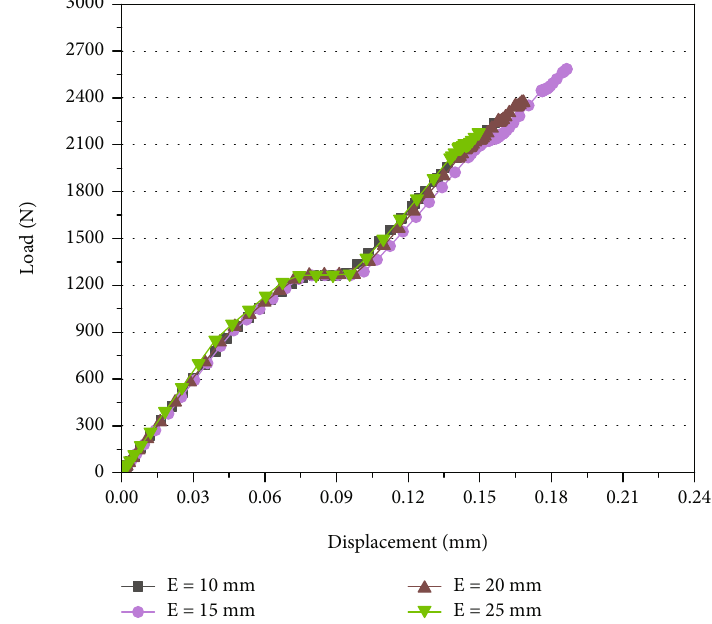
Figure 8: Load – displacement relationships for the C/SiC composite and superalloy double bolted joints under various levels of edge distances at 750 °